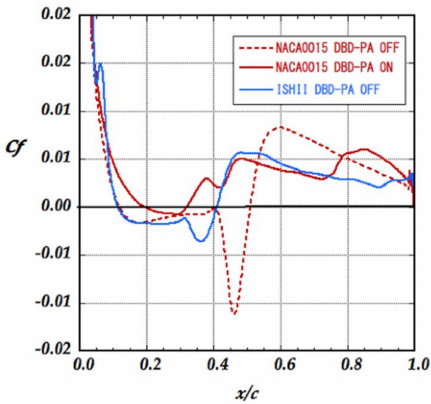
Figure 14. Chordwise skin friction coefficient distributions over the upper surface of the airfoils: NACA0015 ( α = 6 ◦ ), Ishii airfoil ( α = 4 ◦ ), Re = 6.3 × 10 4 , F + = 6.0, Dc = 0.05, BR =